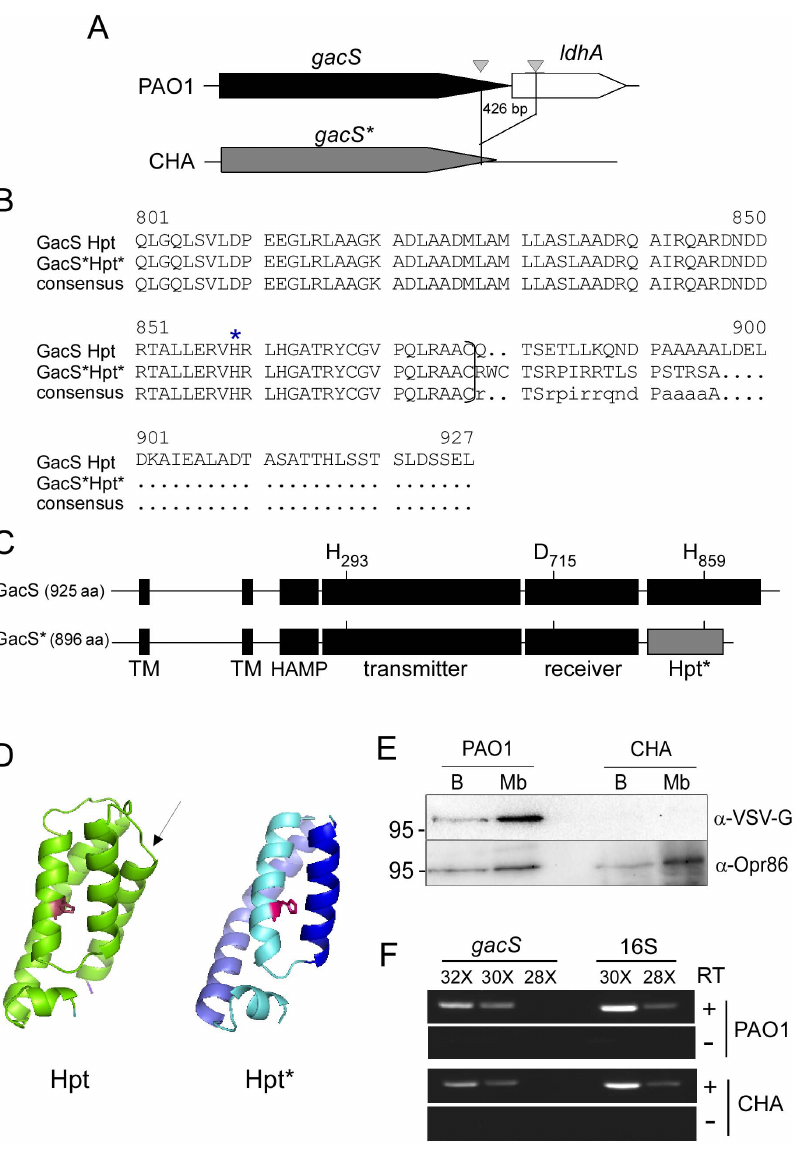
Figure 4. A genomic deletion in CHA affects the GacS regulator. (A) Genetic organization of gacS (PA0928, 2778 bp) and ldhA (PA0927, 990 bp) in PAO1. A 426 bp deletion in the CHA chromosome leads to 3 9 truncated gacS * and 5 9 truncated ldhA gene. The two 11-tandem imperfect repeats located into the PAO1 genes are depicted as arrowheads. (B) Sequence alignment of the Hpt (Histidine phosphotransfer) and Hpt* (truncated domain) domains of PAO1 GacS and CHA GacS*, respectively. The 48 last amino acids of GacS Hpt are replaced by unrelated 19 amino acids in Hpt*, at the position indicated by brackets. The star points to the conserved phosphorylated Histidine 859 residue. (C) GacS* contains all the phosphorylation sites but lacks the C-terminal part of Hpt domain. The length in amino acids (aa) of the proteins is indicated in brackets. TM: transmembrane helix. (D) Modeling of Hpt and Hpt* domains of GacS and GacS*, respectively, using PyMol. One of the helices of the four-helix bundle motif featuring the Hpt domain, that is indicated by an arrow, is missing in the predicted Hpt* domain. (E) Western blot analysis of GacS-VSV- G and GacS*-VSV-G in whole bacteria (B) and in membrane fractions (Mb) of PAO1 and CHA. The blots were developed by antibodies specific to the VSV-G epitope and to the porin Opr86 (PA3648) (loading control) as indicated. Note the absence of GacS*-VSV-G. Localisation of a molecular weight marker is indicated at the left (in kDa). (F) RT-PCR analysis of gacS gene transcript in PAO1 and CHA. The numbers of PCR cycles are indicated. 16S rRNA (16S) transcript levels indicate equal loading. Samples lacking SuperScript III RT enzyme during RT step (- RT) show that no DNA contamination was present. doi:10.1371/journal.pone.0095936.g004 motile CF isolate, with functional flagellum and Type IVa pili that may contribute to its cytotoxic phenotype.